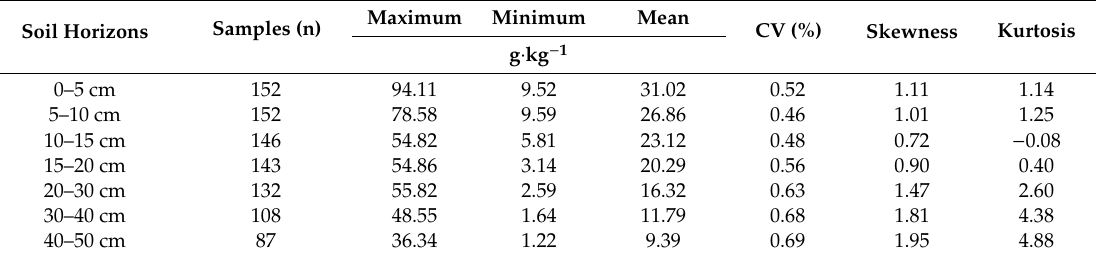
Table 1. Descriptive statistics of the soil organic carbon (SOC) content in soil horizons.